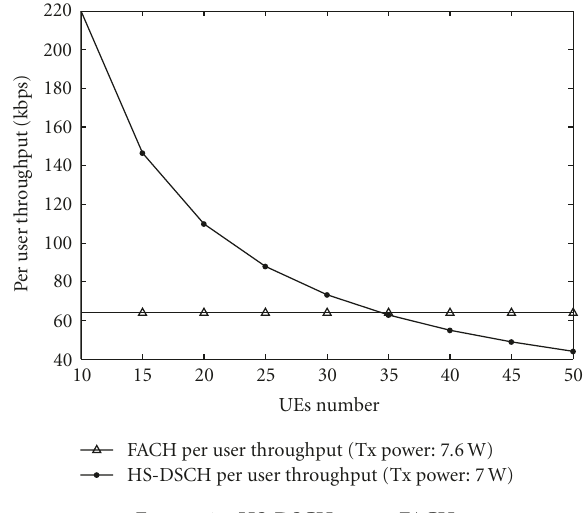
Figure 15: HS-DSCH versus